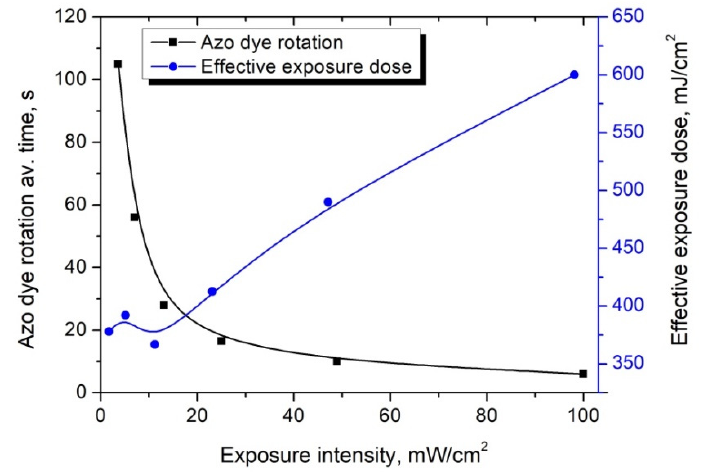
Figure 5. (Color online) Dependence of azo-dye rotation time (or formation of 70 ◦ LC twist angle) on the exposure light intensity from the 440 nm mercury line.